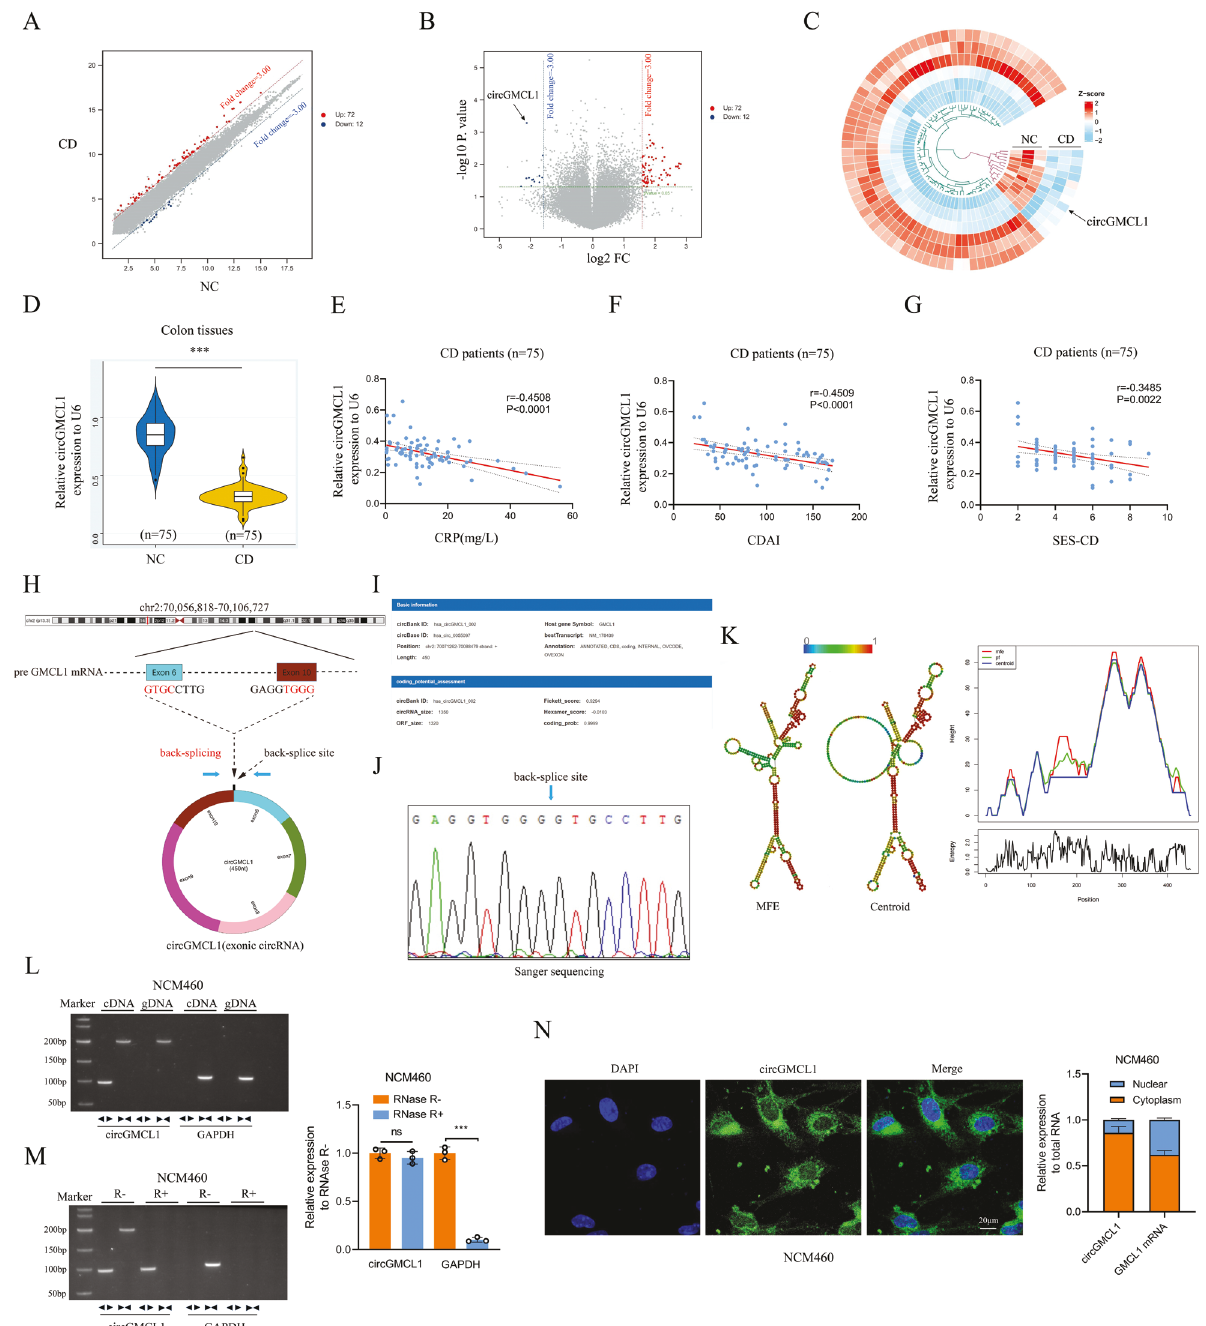
Fig. 1 Identi fi cation of circGMCL1 as the candidate circRNA. Scatter plots A volcano plots B and heatmap C showing circRNA expression pro fi le in colon tissues from CD patients and NCs (threshold: FC > 3, P < 0.05). D Relative circGMCL1 expression in colon tissues from CD patients and NCs as determined by qRT-PCR analysis. Relationship between circGMCL1 expression and CD-associated CRP E , CDAI F and SES- CD G in CD patients ( n = 75). H The circle structure of circGMCL1 back-spliced by exon 6 and exon 10. I The basic information of circGMCL1. J The splicing of circGMCL1 by Sanger sequencing in NCM460 cell lines. K The predicted secondary structures of circGMCL1. L Nucleic acid electrophoresis for circGMCL1 in NCM460 cell lines by RT-PCR. M RNase R experiments by nucleic acid electrophoresis and qRT-PCR analyses. N FISH and qRT-PCR analyses performed to reveal the localization and expression of circGMCL1 in NCM460 cells. circRNA, circular RNA; CD, Crohn ’ s disease; NC, normal control; FC, fold change; qRT-PCR, quantitative real time-polymerase chain reaction; CRP, C-reactive protein; CDAI, Crohn ’ s disease activity index; SES-CD, simple endoscopic score for Crohn ’ s disease, MFE minimum free energy, FISH fl uorescence in situ hybridization. Data are presented as mean ± SD. *** P < 0.001 by Student ’ s t tests. ANXA7 expression exhibited a negative correlation with miR-124- miR-124-3p and ANXA7 in both human and mouse species. qRT- 3p (Fig. 3J) and a positive correlation with circGMCL1 (Fig. 3K) in PCR analysis results showed that the relative ANXA7 expression CD patients. Collectively, these results strongly support the ceRNA levels in colon tissues (Fig. 3H) and isolated epithelial cells (Fig. 3I) theory of circGMCL1. were both lower in CD patients than in NCs. Moreover, relative Cell Death and Disease (2022)